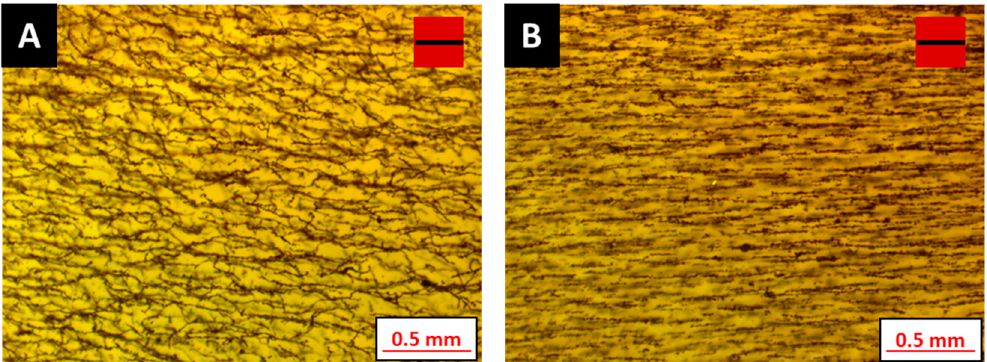
Figure 9. Micrographs obtained from the experiments adopting machine configuration scenarios ( A ) and ( B ), as indicated in Figure 7. Red squares with a black bar indicate the direction of the magnetic field.